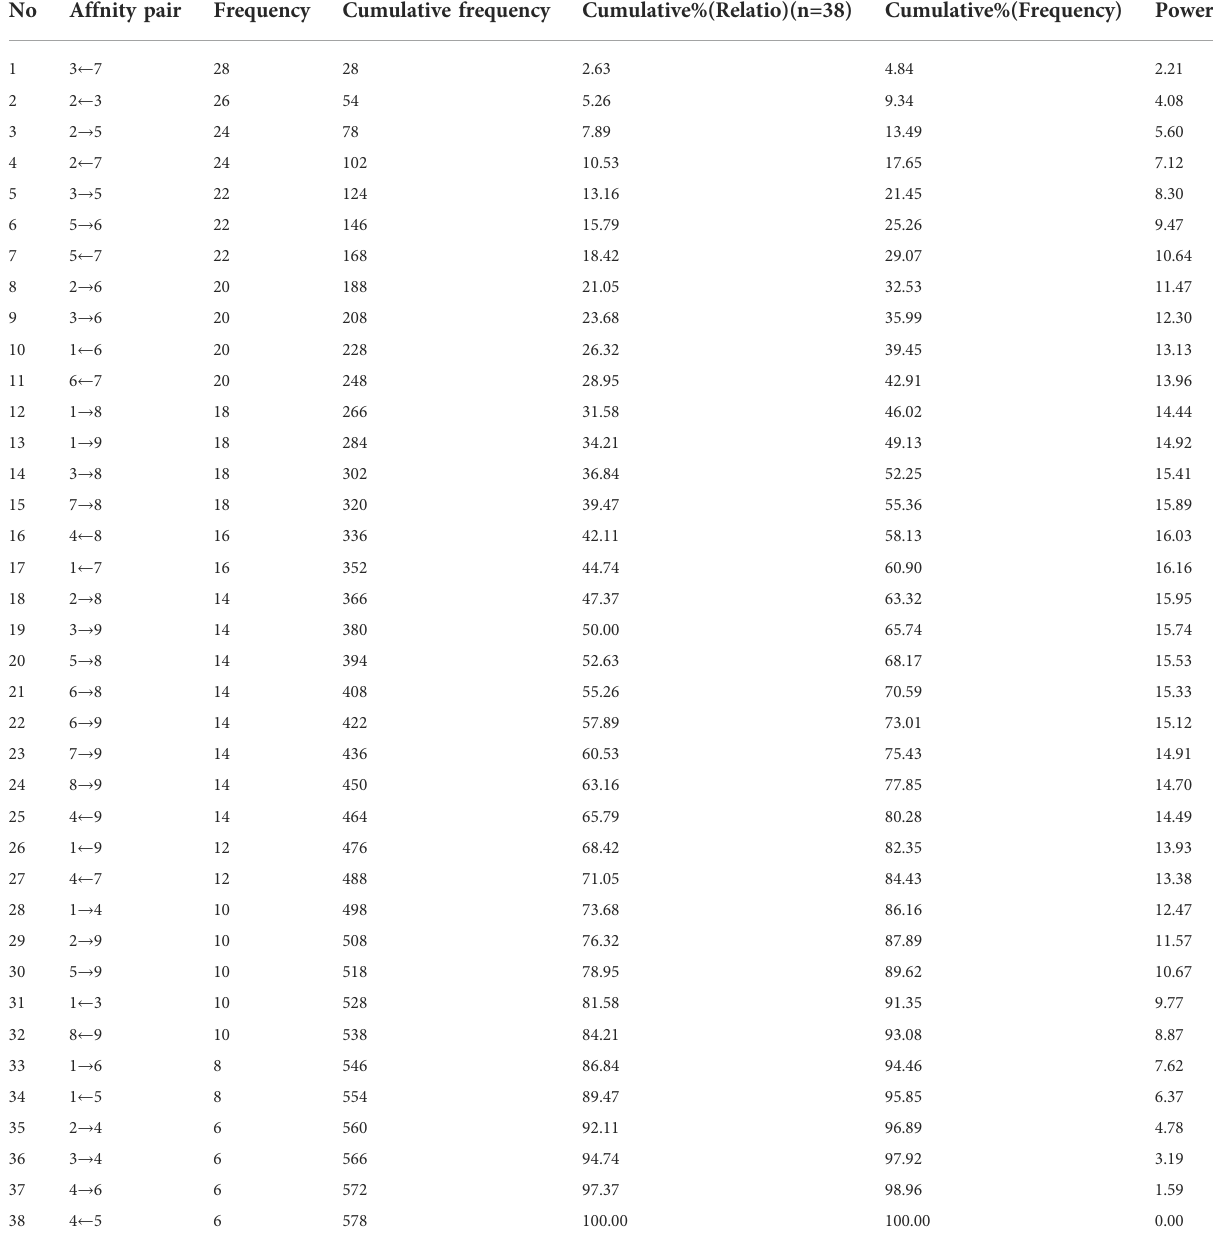
TABLE 8 Af fi nity optimal